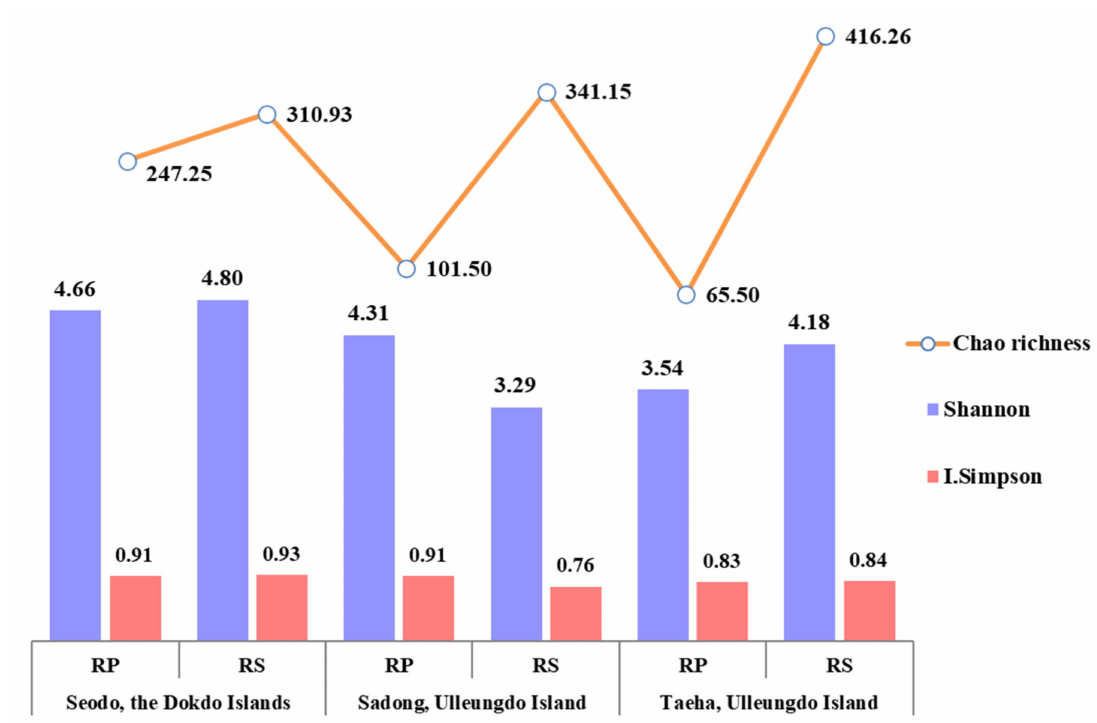
Figure 3. Fungal diversity variation in the RP and RS